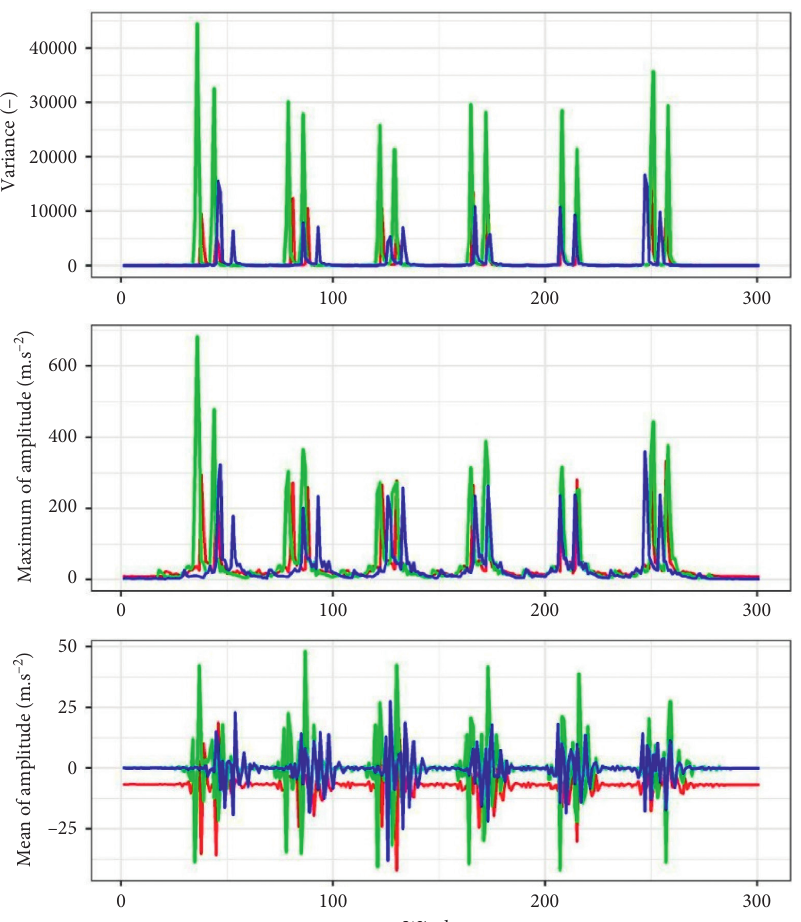
Figure 6: LEO Express train signal windowed variance (three passages). Window size: number of samples/300. Top: windowed variance value. Middle: windowed maximum. Bottom: windowed mean.